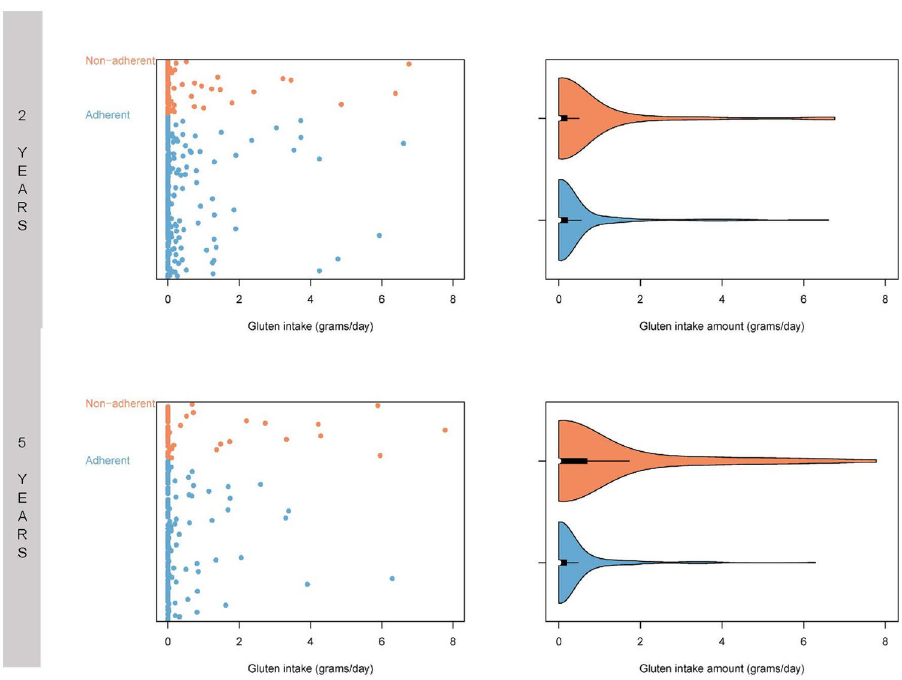
Fig 3. Gluten intake. Mean gluten-intake based on 3-day food records in subjects adherent and nonadherent to a gluten-free diet at 2 and 5 years post the diagnosis of celiac disease. One slice of white bread is roughly equivalent to 2 grams of gluten